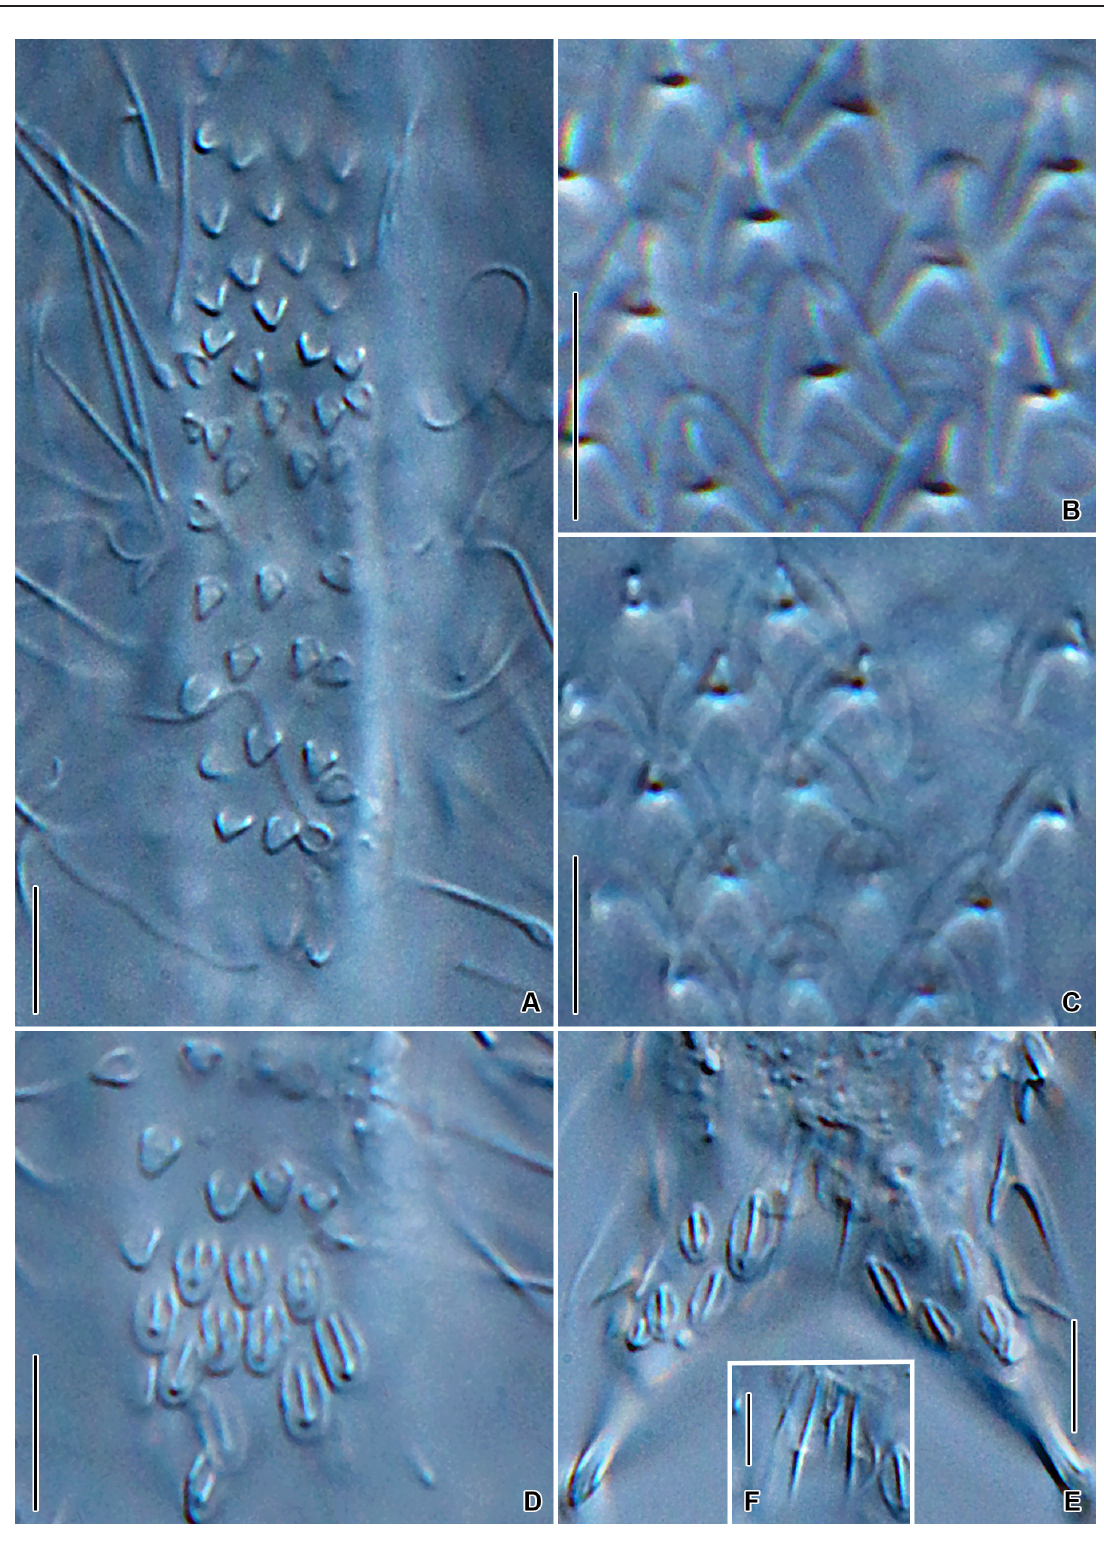
Fig. 22. Chaetonotus ( Hystricochaetonotus ) optabilis sp. nov., differential interference contrast. A, D–F . Paratype (CU-FNS-05-03-20-3/PA-2). B–C . Holotype (CU-FNS-05-03-20-1/HO). A . Scales in the ventral interciliary field. B . Trunk scales. C . Head scales. D‒E . Details of the ventral posterior body region. F . Oblong spined scales. Scale bars: A‒E = 5 µm; F = 2